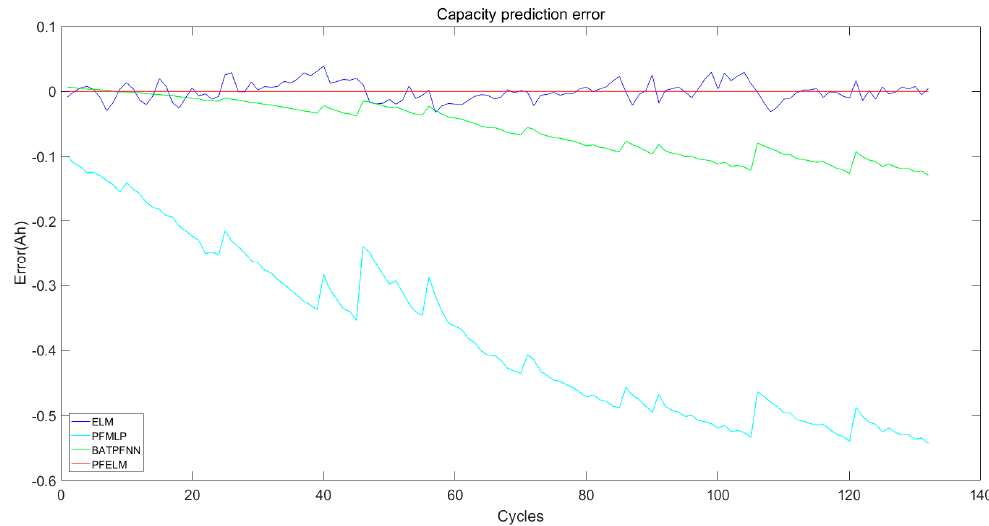
Figure 23. Capacity prediction error from the first cycle.